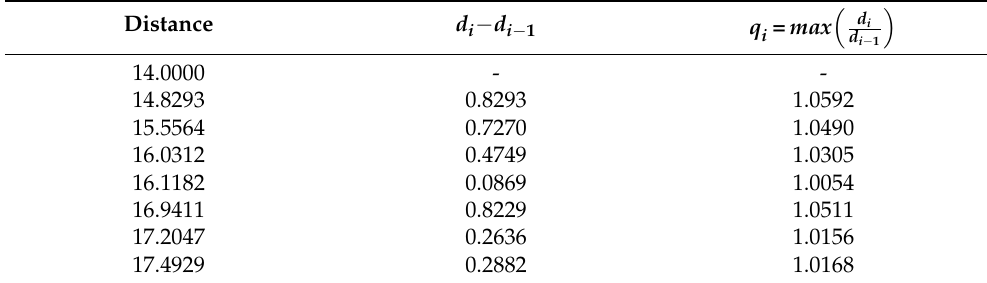
Table 3. Detailed measures of distance and measures calculated as differences and quotients of